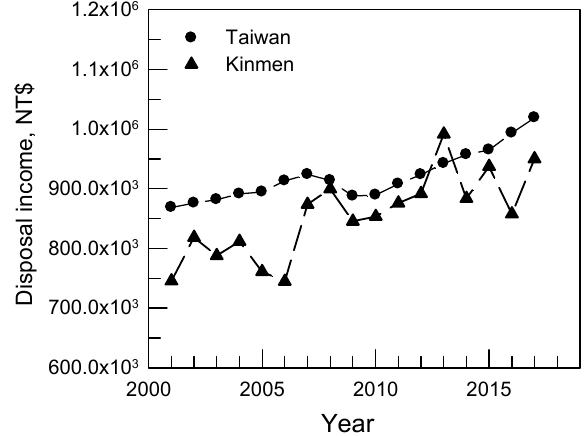
Figure 5. Average disposable income per household in Taiwan and Kinmen County.